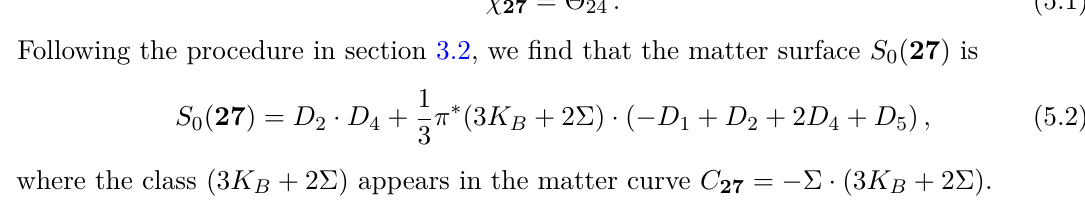
There are still other flux constraints remaining such as primitivity. Solving these constraints will be demonstrated in section